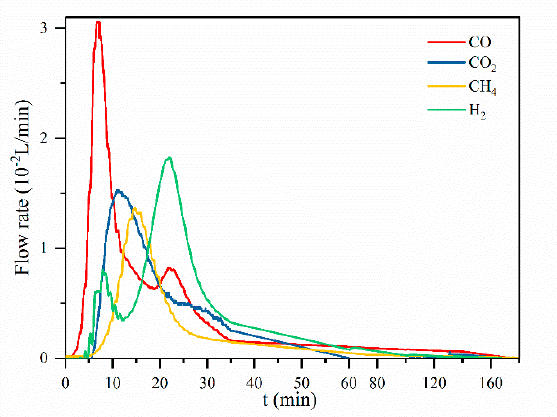
Figure 2. Evolution of syngas composition during the pyrolysis process at 650 °C.